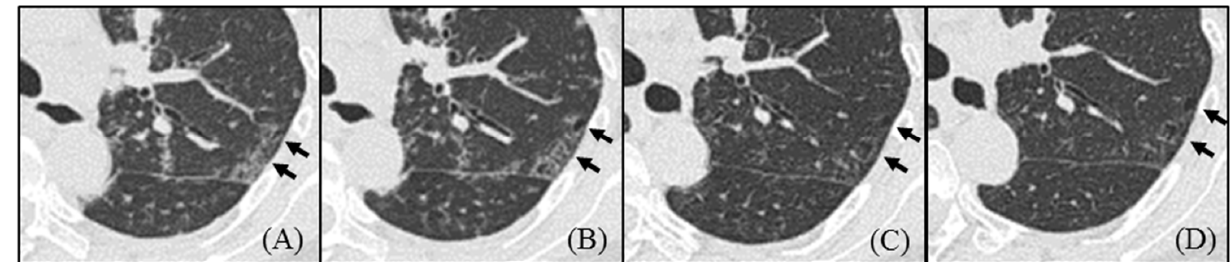
Figure 5. The course of high-resolution computed tomography imaging of case presentation